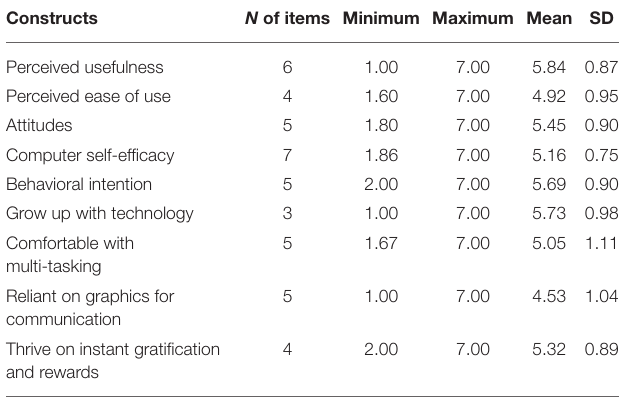
TABLE 1 | Information of the